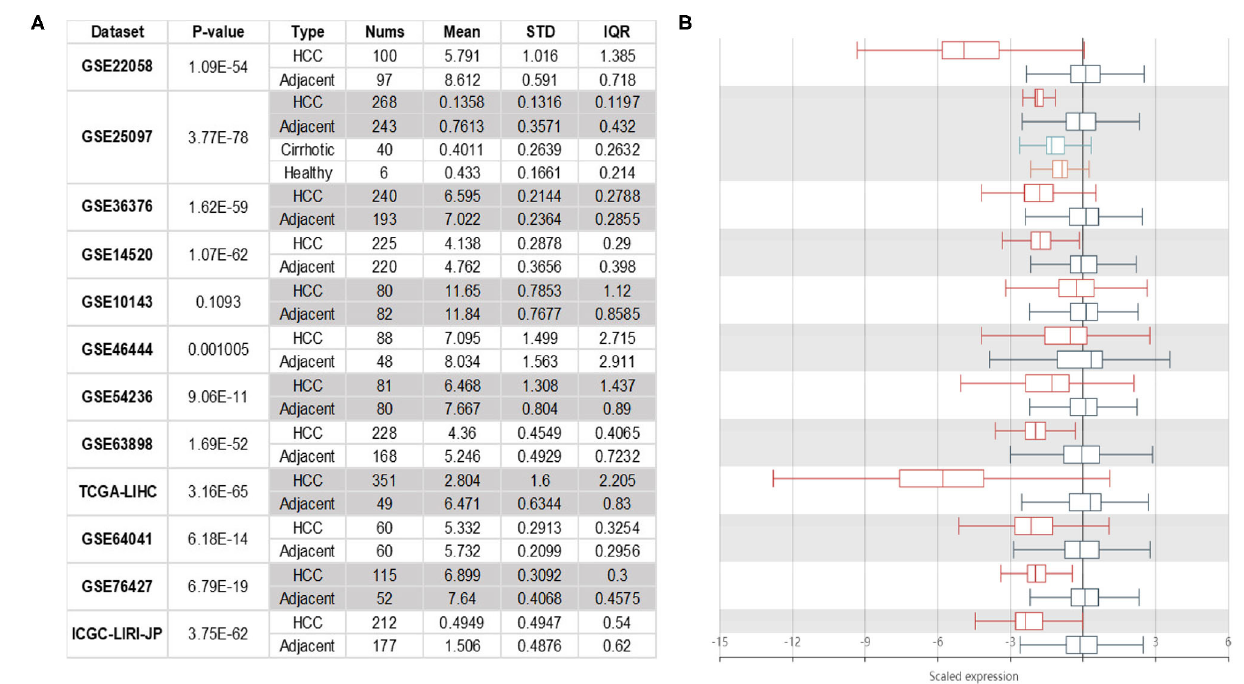
the proportions of 22 different TIICs between samples with high and low NTF3 expression as previously